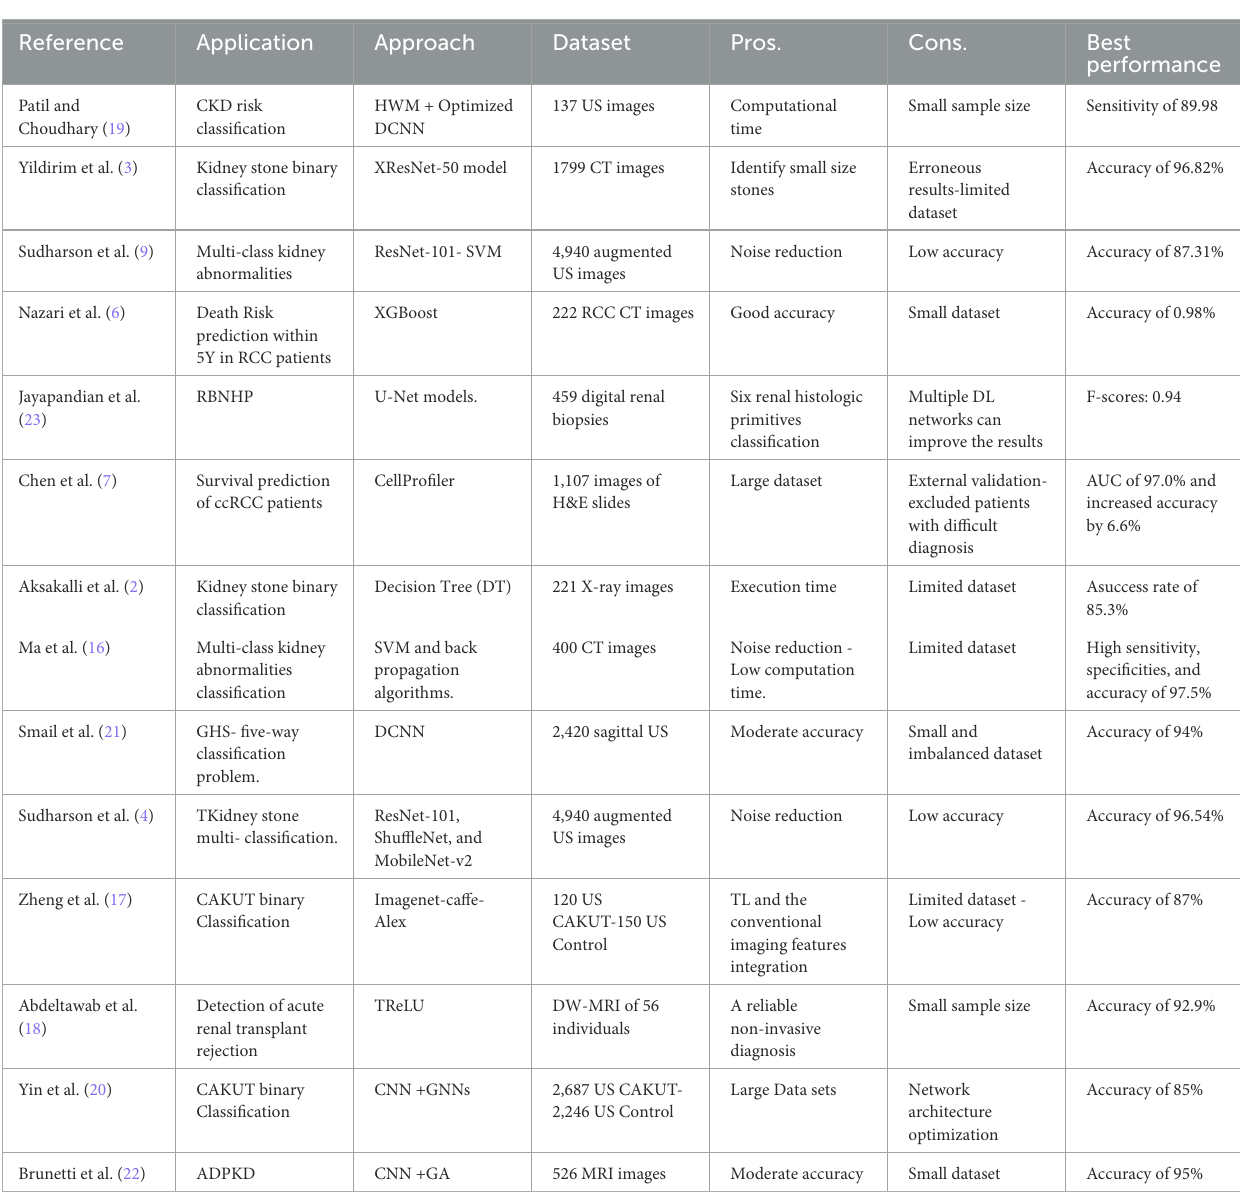
TABLE 2 Related studies